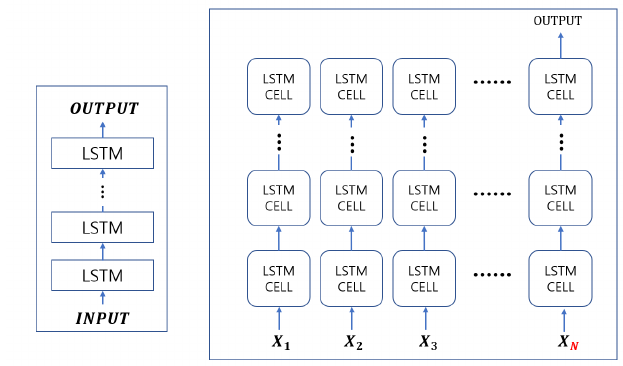
Figure 5. Stack LSTM architecture.